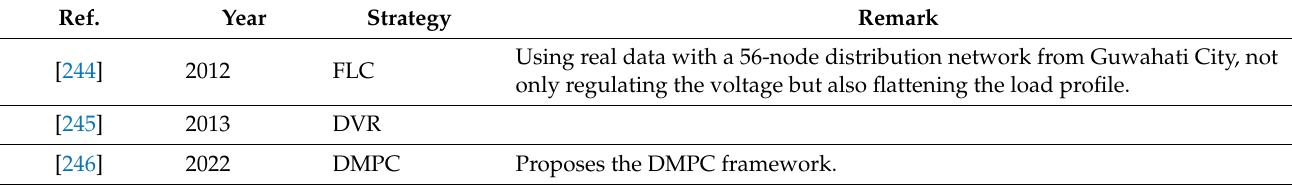
Table 7. EVAS as a voltage regulation